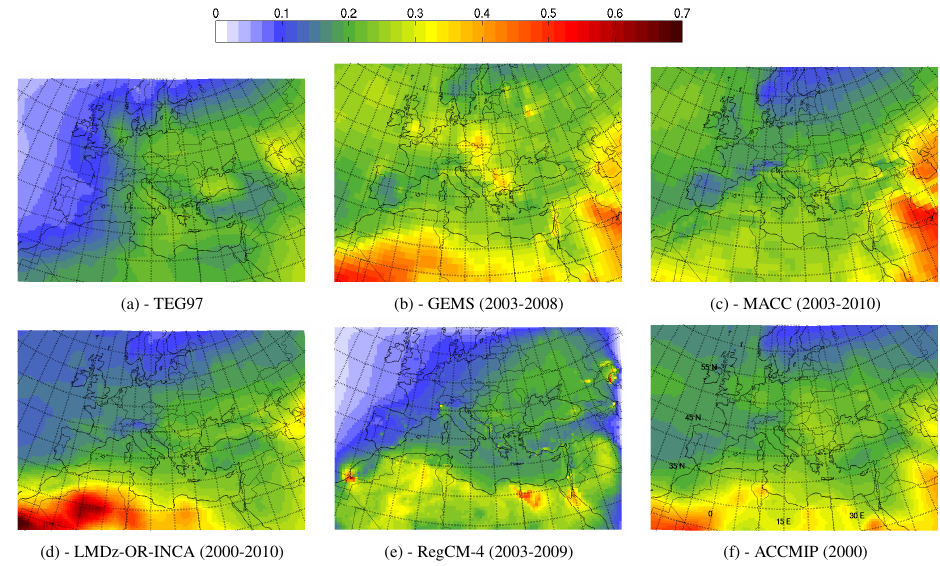
Fig. 3. Mean Aerosol Optical Depth (AOD) at 550 nm from different model-simulated products over the Mediterranean region.